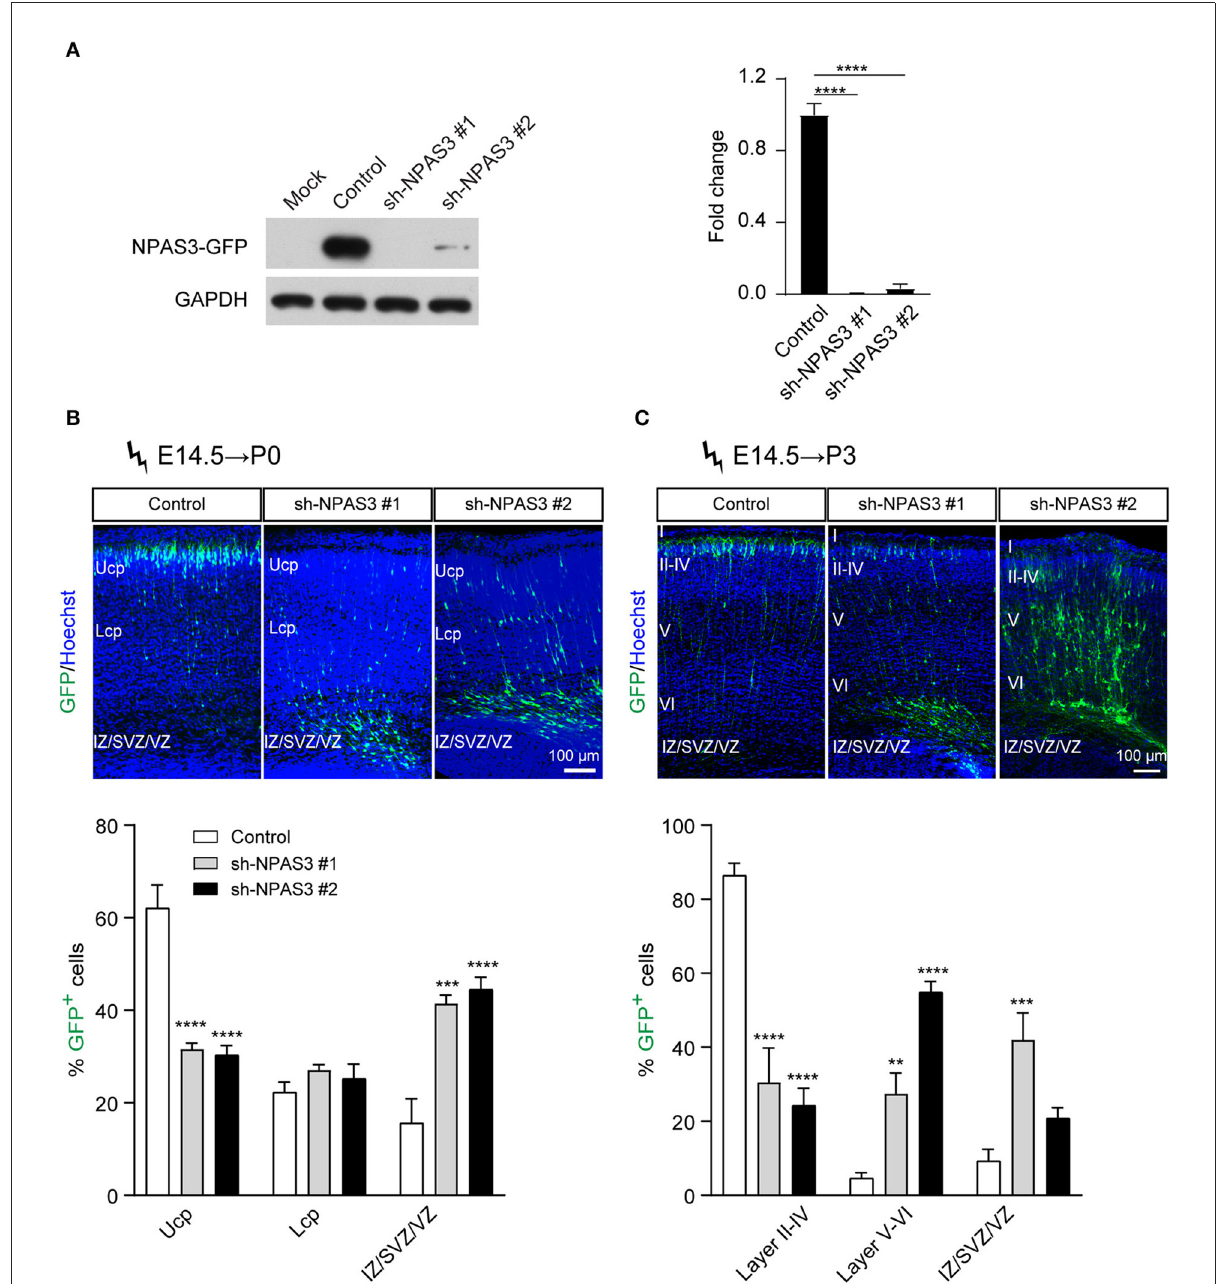
FIGURE2 Npas3 downregulation impaired neuronal radial migration in vivo . (A) Non-transfected HEK293T cells (mock) or cells transfected with an expression plasmid encoding mouse NPAS3-GFP protein together with Npas3 shRNAs or control pSuper-basic plasmid were lysed 48h after transfection and processed to Western blot analysis with anti-GFP and anti-GAPDH antibodies. Quantification of the relative protein levels is shown in the right panel. Data are presented as mean ± SEM ( n = 3). One-way ANOVA test, **** p < 0.0001. GAPDH was used as a loading control. (B) and (C) Positioning defects of Npas3 -knockdown cells. E14.5 mouse embryos electroporated with Npas3 shRNAs or control pSuper-basic plasmid together with a GFP expression plasmid were allowed to develop until P0 (B) and P3 (C) . Electroporated cells are in green, and nuclei are in blue. Quantification of cell position is shown on the right panel. Data are presented as mean ± SEM ( n = 3–5). Two-way ANOVA test, ** p < 0.01, *** p < 0.001, **** p < 0.0001. Ucp, upper cortical plate; Lcp, lower cortical plate; IZ, intermediate zone; SVZ, subventricular zone; Cortical layers are labeled I–VI. Scale bar, 100 µ